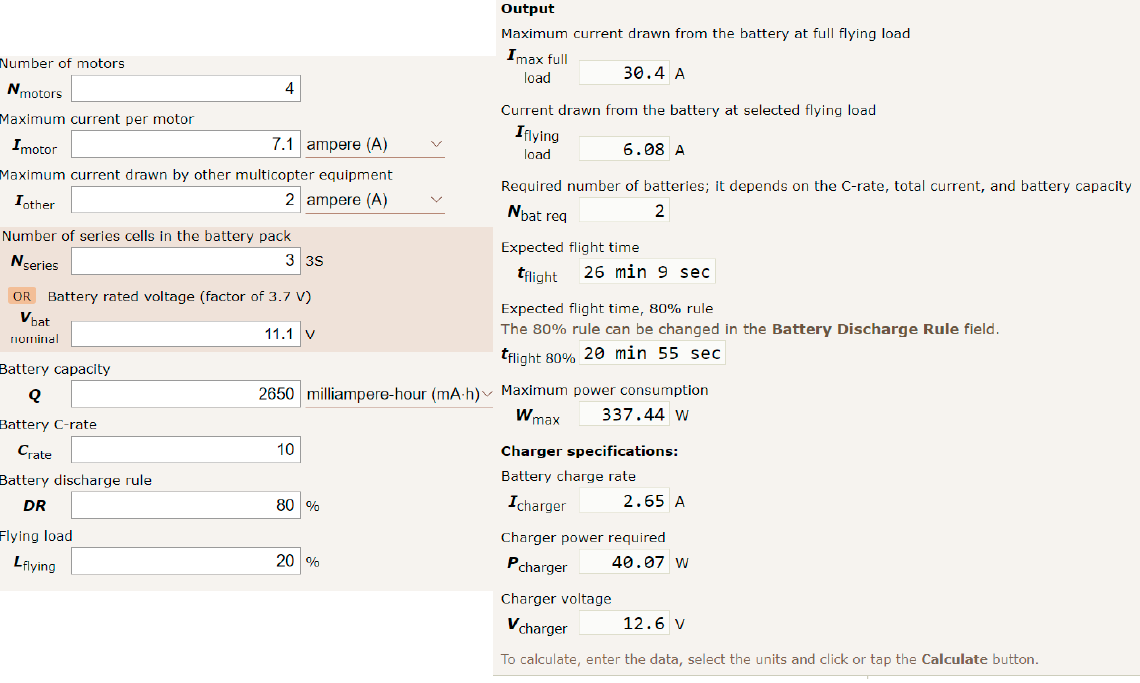
Figure 11. I nformation calculated for UAV flight, according to the UAV and battery capabilities. Figure 11. Information calculated for UAV flight, according to the UAV and battery As can be inferred from the previous information, collecting information with UAV flights is plausible and the data collected is of interest. Furthermore, it can be obtained with a significantly cheaper and faster solution rather than using a team of technicians and/or engineers with their equipment. However, as appealing as this solution might be, it requires further processing after the information has been collected. The data collected must be visualized in a way that can be used by end users, regardless of their knowledge on the topics shown in this paper. As previously described, that is why a GUI was devel- oped to display the most relevant data. The data collected under these experiments can be used as an example on how the GUI works, so that the information provided can be further extended: to begin with, the data collected from the CSV files obtained from the application installed in the smartphone used as MDAS will be loaded to the GUI by using a regular file explorer tab. Once the file has been loaded, information pre-processing will take place so that noise-related values are removed. Figure 12 shows how the GUI can display several pieces of relevant information, such as carrier-to-noise ratios for the two carriers used in data transmission for the Galileo GNSS and the signal level obtained as a representation of the collected data. Information shown in this figure is strictly related to the data collected by the drone, so it is a representation of the data shown in Figure 10, along with further data displayed in the GitHub link shown in [37]. As can be seen, data can be displayed in a user-friendly manner so that end users of the system will be able to infer knowledge from the drone missions in a fast way. There are also other actions that can be carried out with the GUI. As explained in Section 3, signal measurements can be represented over a map to better grasp the implications of the collected data in terms of actual coverage. As depicted in Figure 12, the information collected shows signal power measurements over a map, which reveals what locations or infrastructures are better cov- ered by the 4G LTE signal and which ones have poorer signal values.